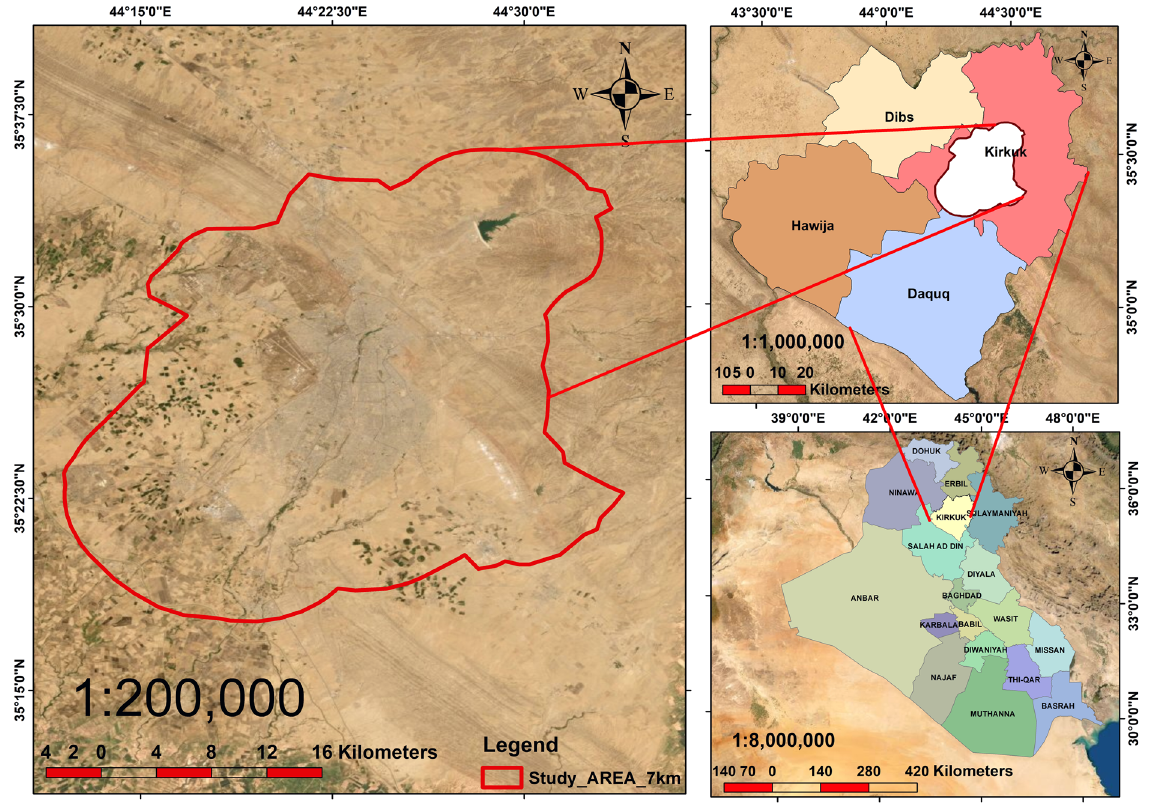
Figure 1: Localization of Kirkuk city using GIS